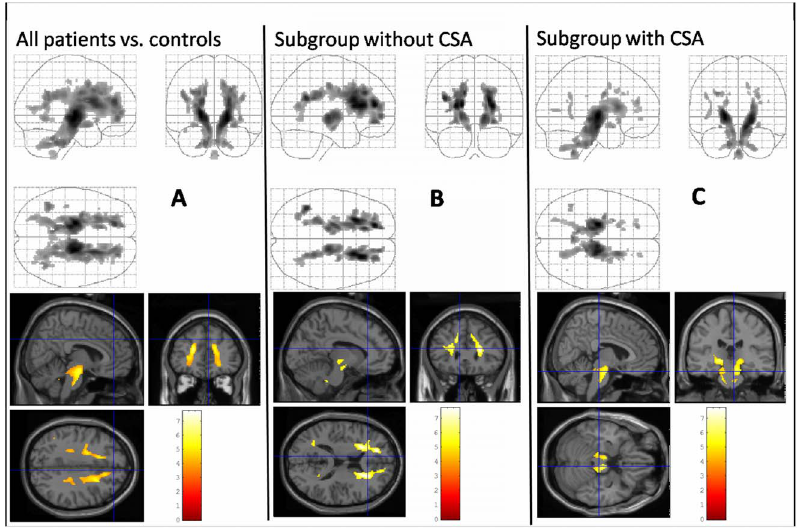
Figure 1. SPM "glass brain" representations (upper row) and statistical FA maps that were superimposed on a normalized T1- weighted template (lower row) showing clusters of microstructural damage of the FD patient group compared to healthy controls (ANCOVA, modelling age as a co-variate; p , 0.001, corrected for multiple comparison; minimum of 50 contiguous voxels). Coloured bars represent t-values; display threshold is set at t value . 3.16. A: FA values of the complete FD patients group (n=23) were significantly reduced in WM areas covering widespread parts of the brain, indicating structural WM changes extending beyond the WM lesions that showed up on conventional MRI. B and C: Subgroup analyses of both patient groups (without (1B; n=18) and with (1C; n=5) CSA-CSR), relative to the healthy controls (n=44). Clusters of FA changes in patients with CSA-CSR were most pronounced in the brainstem. By contrast, FD patients without CSA-CSR revealed more widespread FA decreases in supratentorial areas, but only subtle brainstem involvement. SPM = Statistical Parametric Mapping; FD=Fabry Disease; FA=Fractional Anisotropy; WM=White Matter; MRI=Magnetic Resonance Imaging; CSA-CSR=Central sleep apnea with Cheyne- Stokes respiration.